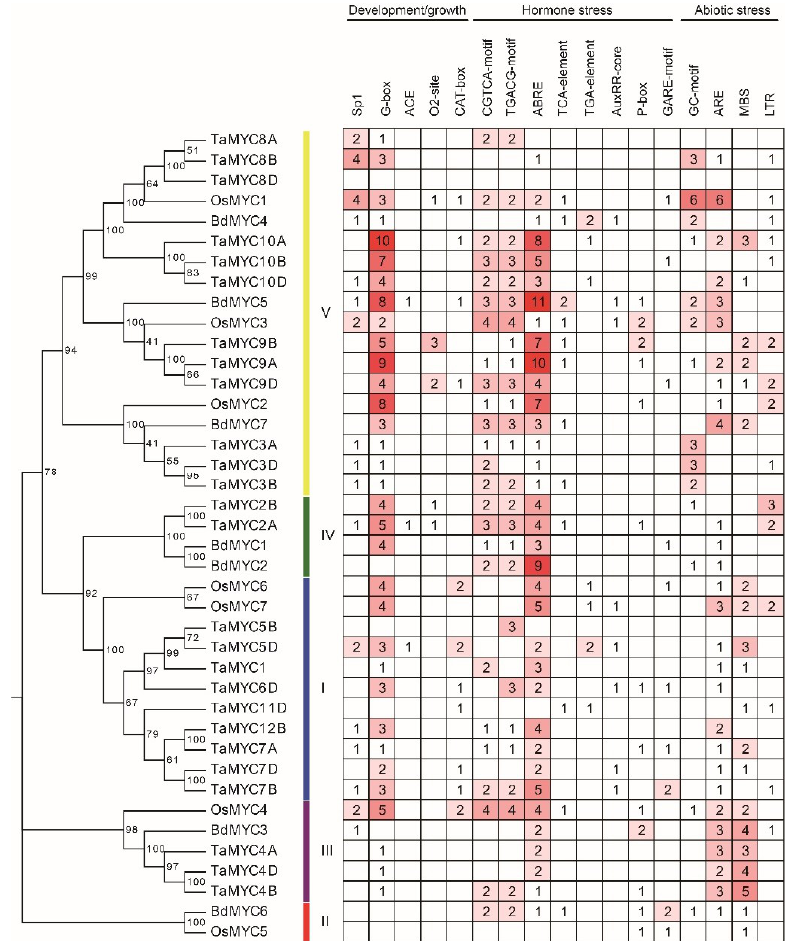
Figure 5. Main cis ‐elements in TaMYC , OsMYC , and BdMYC gene promoters. Figure 5. Main cis -elements in TaMYC , OsMYC , and BdMYC gene promoters.